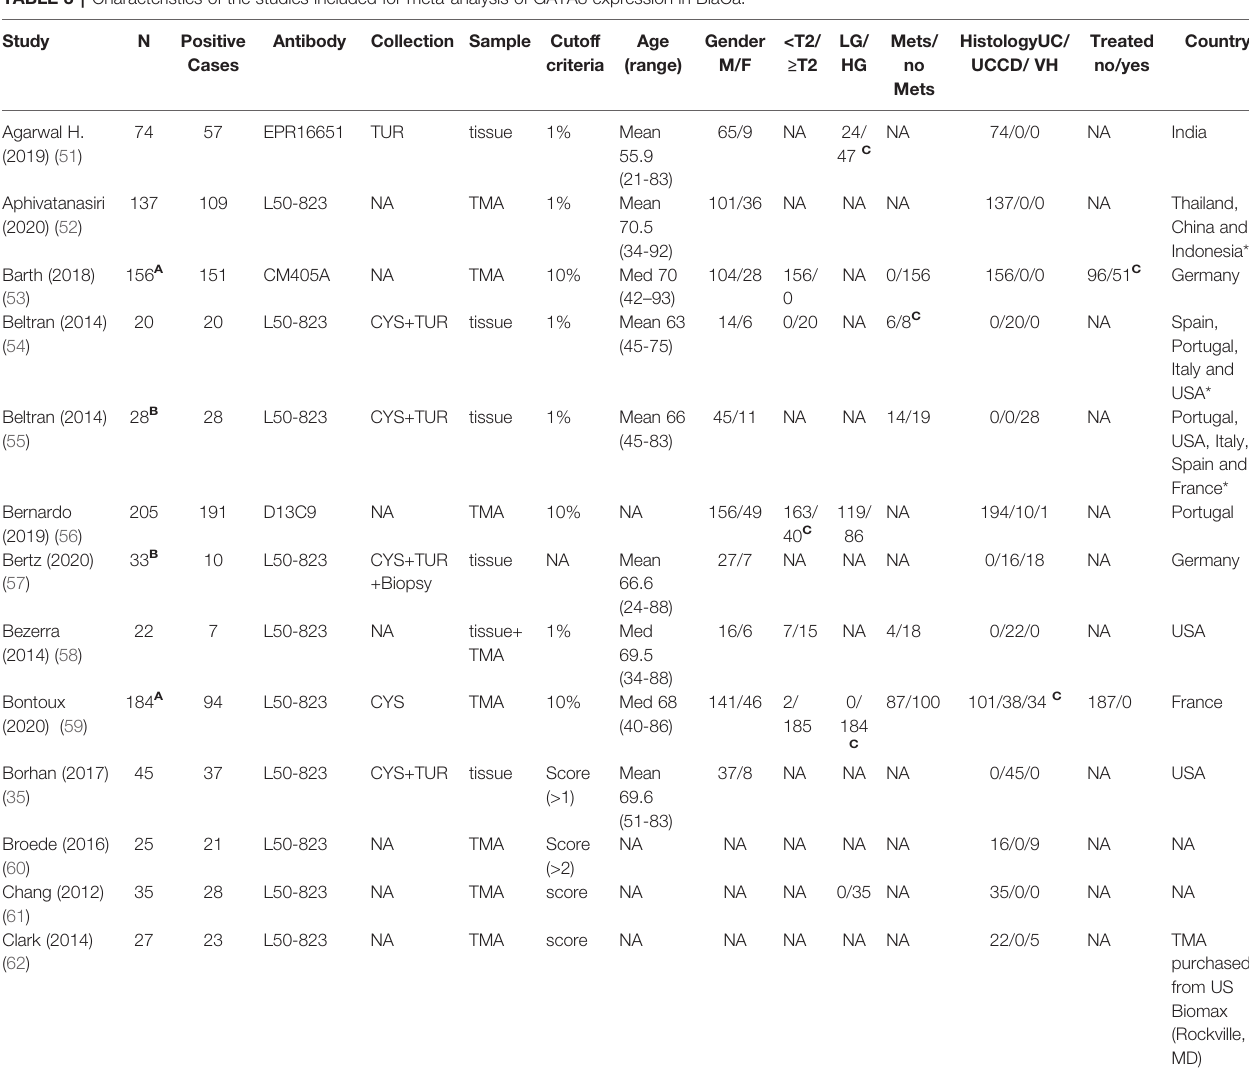
TABLE 3 | Characteristics of the studies included for meta-analysis of GATA3 expression in